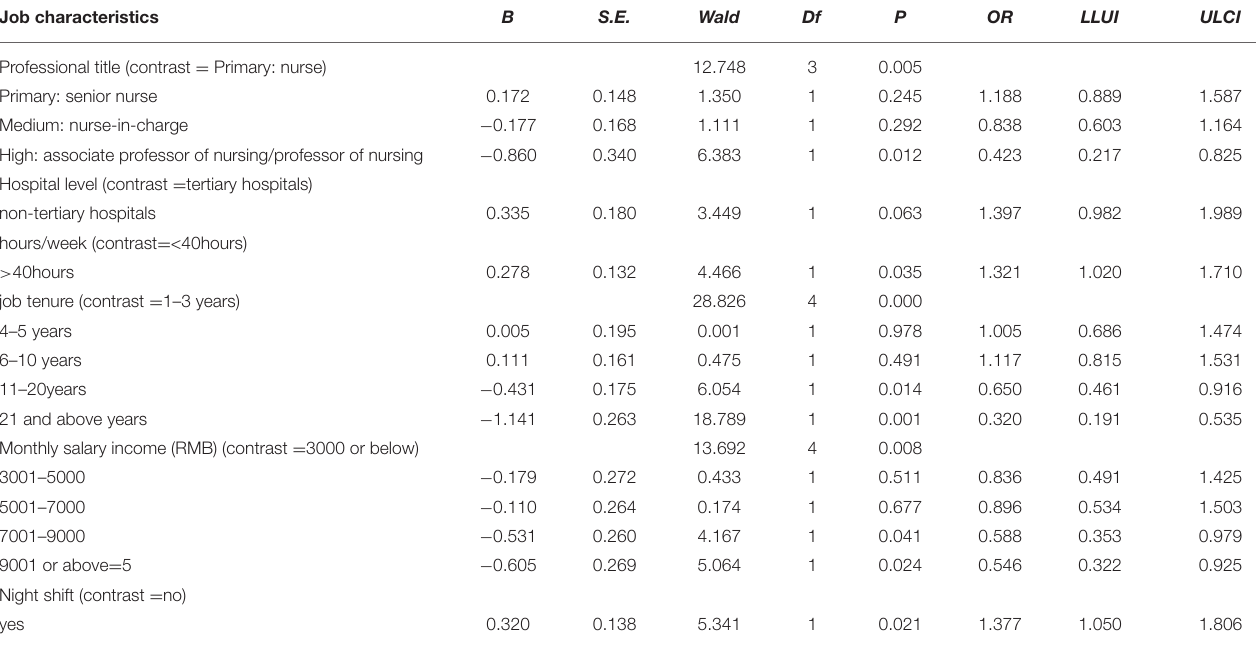
TABLE 5 | Univariate logistic regression analysis of respondents ( n =